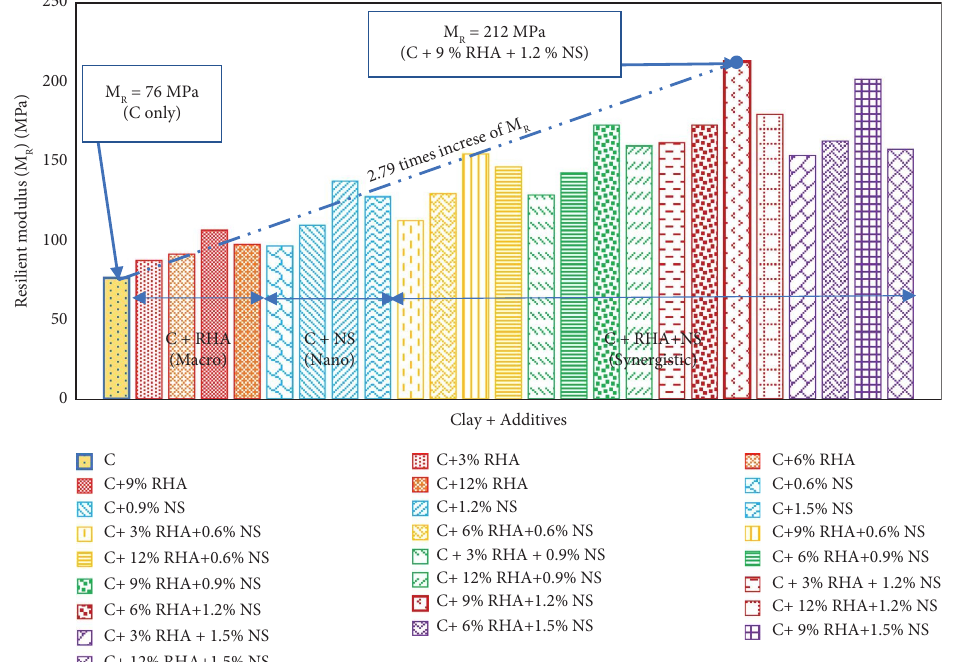
Figure 7: MR of clay and blends of clay plus RHA and